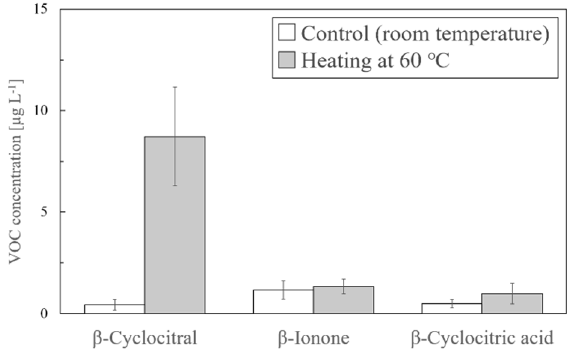
Figure 1. Analysis of three VOCs by the solvent extraction with heating ( n = 7).